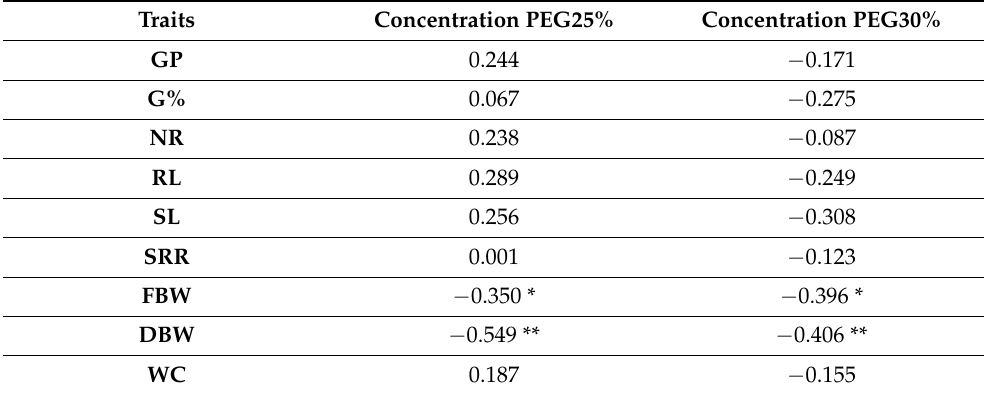
Table 4. Correlation between the germination traits under both treatments (PEG25% and PEG30%) with the drought tolerance index (DTI) at the seedling stage; taken from Ahmed et al. [21]. Traits Concentration PEG25% Concentration PEG30% GP 0.244 − 0.171 G% 0.067 − 0.275 NR 0.238 − 0.087 RL 0.289 − 0.249 SL 0.256 − 0.308 SRR 0.001 − 0.123 FBW − 0.350 * − 0.396 * DBW − 0.549 ** − 0.406 ** WC 0.187 − 0.155 Germination pace (GP); Germination percentage (G%); Number of root (NR); Root length (RL); Shoot length (SL); Shoot-root length ratio (SRR); Fresh biomass weight (FBW); Dry biomass weight (DBW); Water content